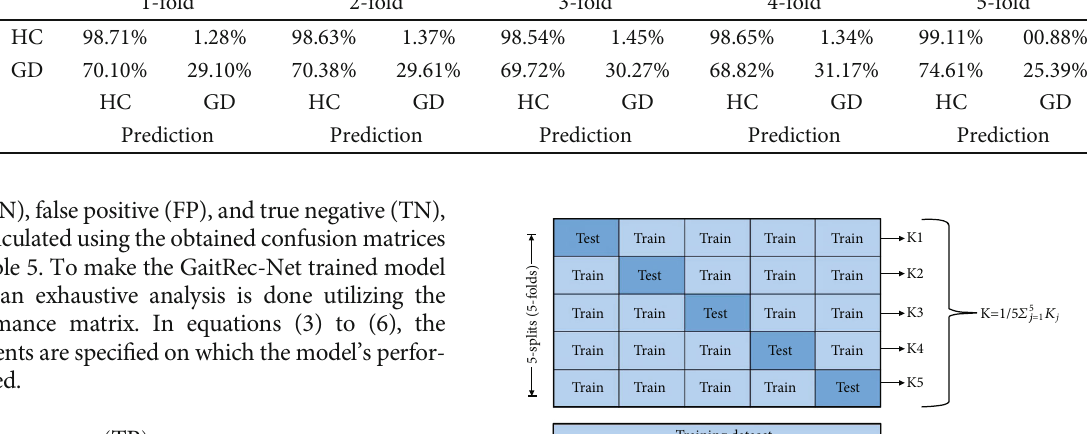
Table 5: The confusion matrix for the proposed GaitRec-Net model on the GaitRec dataset. 1-fold